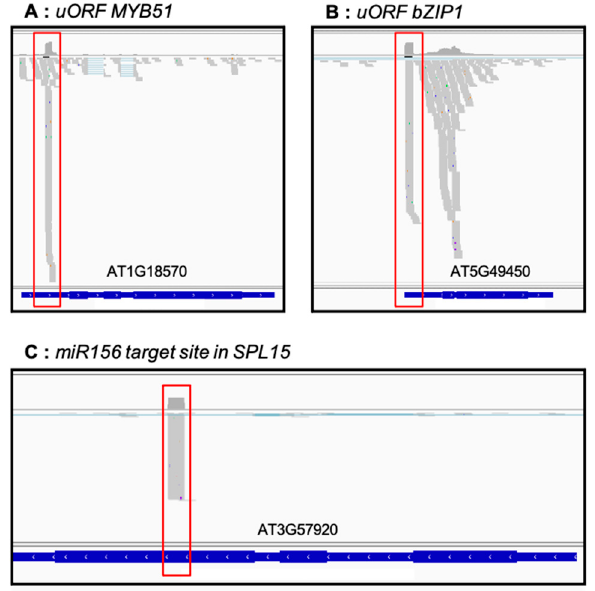
Figure 6. 5 ′ P degradome data allows identification of ribosome stacking at uORF or 5 ′ P reads ac- cumulation at miRNA cleavage site. Genome viewer of 5 ′ P reads accumulation along At1g18570 ( A ), At5g49450 ( B ) and At3g57920 ( C ). Regions corresponding to uORF or miRNA cleavage site are highlighted in red. Grey marks correspond to 5 ′ P reads accumulation.